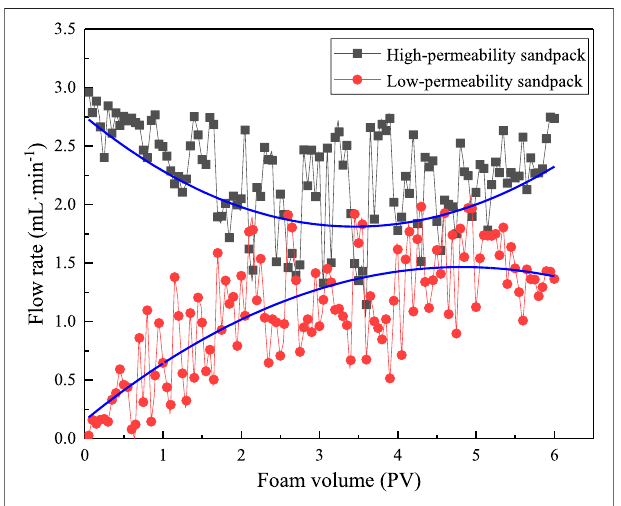
FIGURE9| Heat-resistantCO 2 foampro fi lecontrolability.(Temperature was90 ° C,back pressurewas0.5MPa, foam injection ratewas5 mlL · min − -1 ).